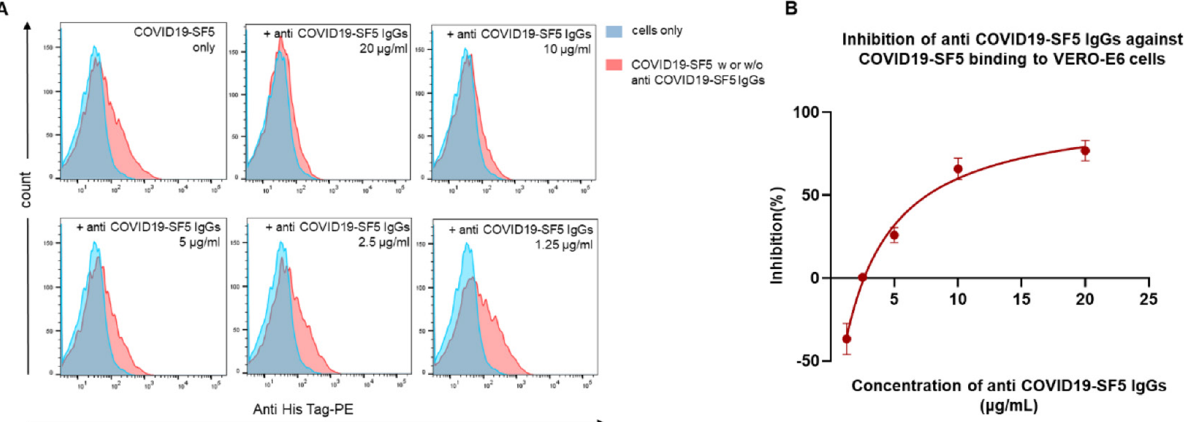
Figure 5. The inhibition of anti-serum antibodies of COVID19-SF5 on COVID19-SF5 binding to cells. ( A and B ) Flow cytometry to detect the effect of IgGs against COVID19-SF5 (0–20 μg/mL) on COVID19-SF5 (0.25 μM) binding to VERO-E6 cells. The blue curves represent the blank control (cells only). The red curves represent the binding of COVID19-SF5 itself or with various concentrations (1.25–20 μg/mL) of anti-serum antibodies against COVID19-SF5. A representative curve of concentration-dependent inhibition was shown in ( B